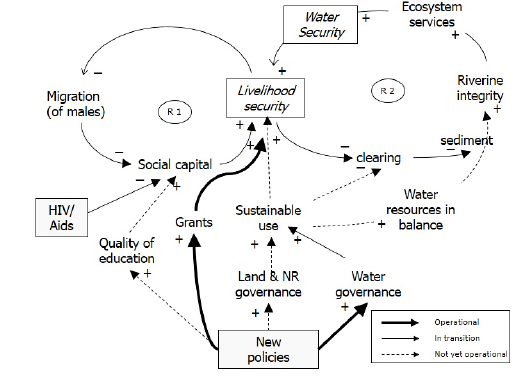
Fig. 3 . Causal–loop diagram exploring a systemic view of water security in the Sand River Catchment social-ecological system for the postapartheid era (after